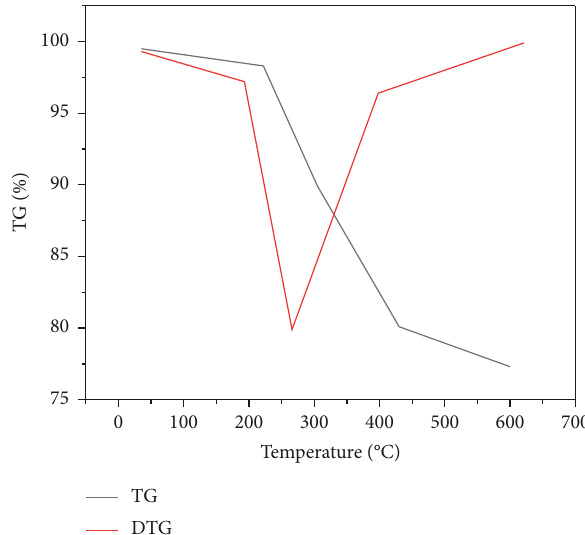
Figure 5: Slurry viscosity and surface roughness after core sintering.